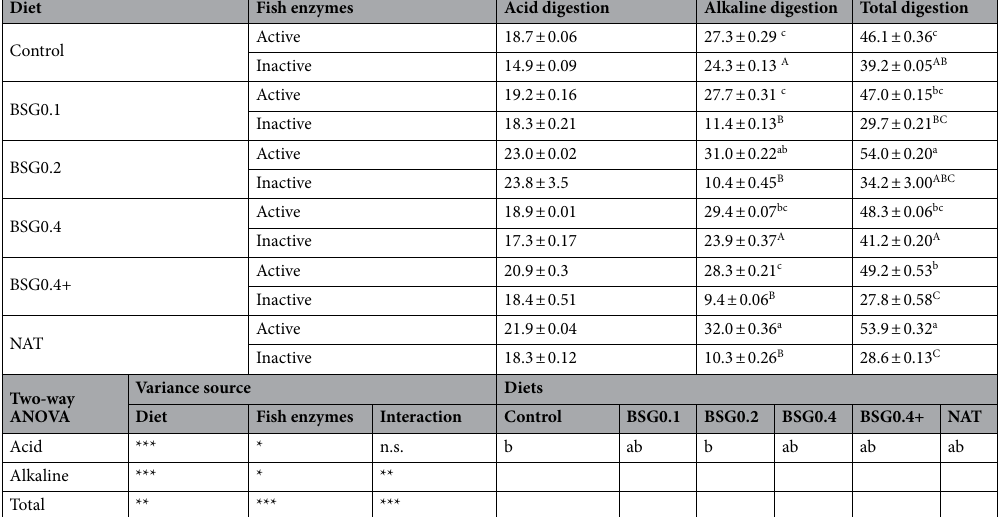
Table 6. Amino acids release (mg g −1 diet h −1 ) during the gastric, intestinal, and total in vitro digestion. Values presented as mean (n = 3) and standard deviation (SD). Two-way ANOVA testing for the effect of the diets (control, BSG0.1, BSG0.2, BSG0.4, BSG0.4 + ; NAT) and fish enzymes (active and inactive): * p < 0.05; ** p < 0.01; *** p < 0.001; n.s.: not significant. If the interaction was significant, one-way ANOVA was performed testing the effect of the diets during digestion with active (lower letters) or inactive fish enzymes (upper